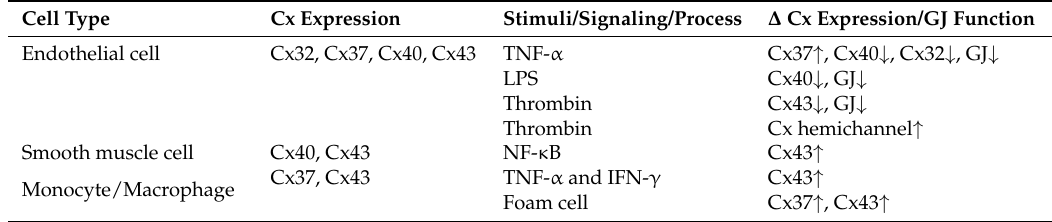
Table 1. Cx expression in vascular component cells and alteration of Cx expression/GJ function upon stimuli. Cell